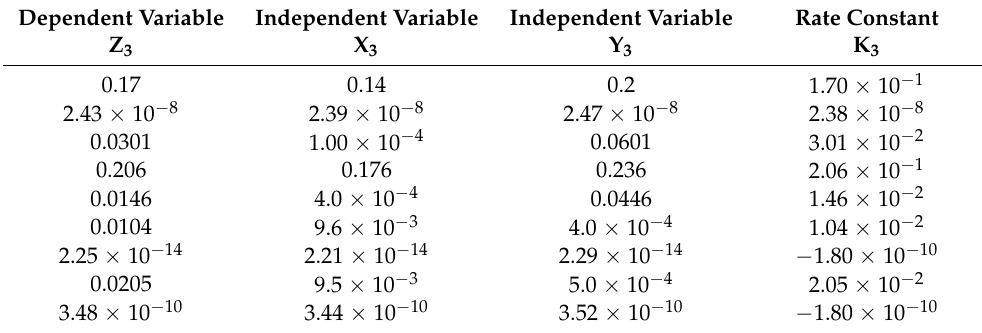
Table 6. Multiple linear regression model with a difference of 0.04 from the experimental fixed value at 420 ◦ C. Where ‘***’ show a statistically significant value.